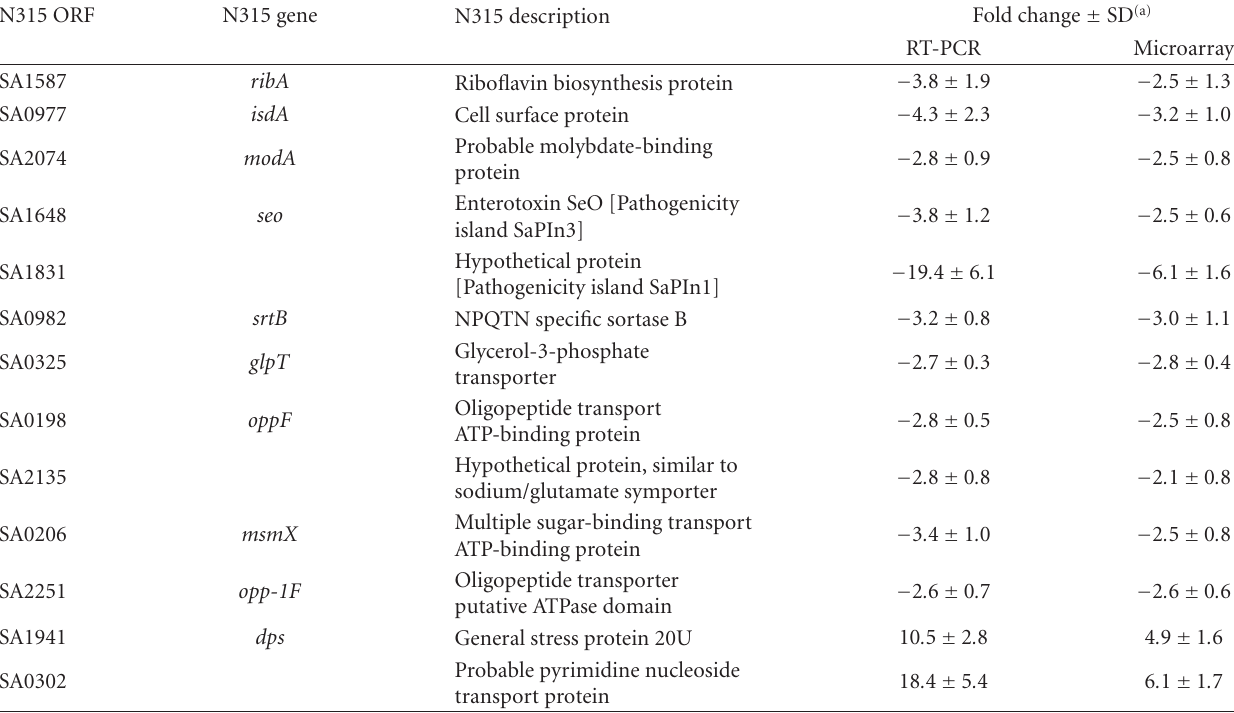
Table 3: Real-time RT-PCR analysis of gene